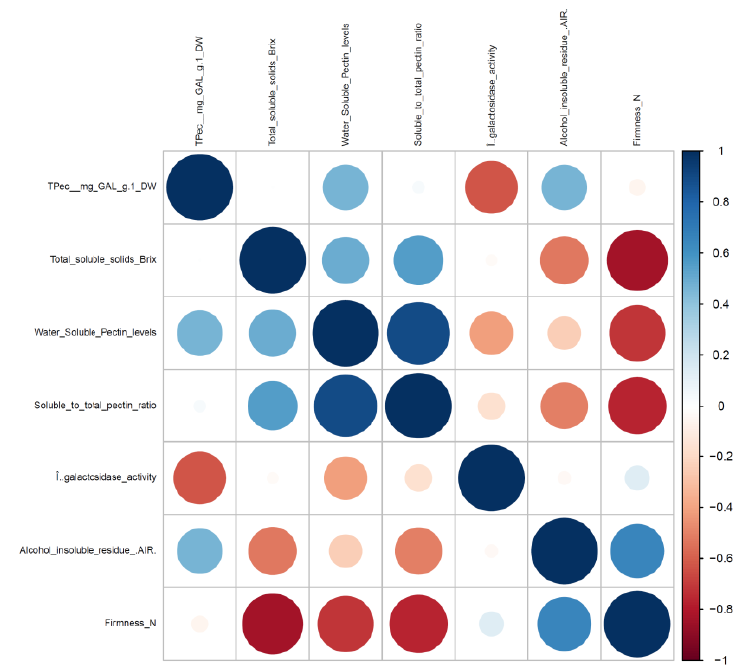
Figure 1. Positive, neutral, and negative affinities across traits in Solanum lycopersicum L. cv. Chon- drokatsari. Plants were cultivated across maturity stages (CM, RR) and postharvest treatments (5 d 4 °C, 5 d 10 °C, 5 d 25 °C). Positive correlations are portrayed by blue circles, while negative associ- ations are indicated by red circles. The intensity of color corresponds to the correlation coefficient (r) ranging from -1 to 1 (scale). The larger size of circles indicates statistically significant values (non-significant, p = 0.05, p = 0.01, p = 0.001 respectively).